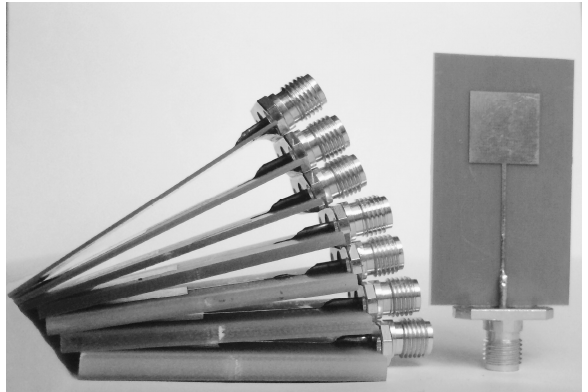
Figure. 2. The eight manufactured antennas. The standing one is B 8 , SF=0.078125.